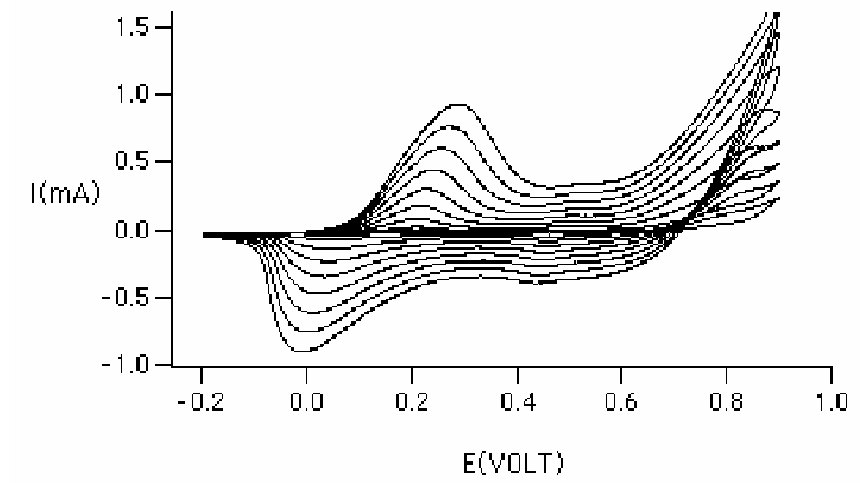
Figure 4 . Cyclic voltammograms (CV) recorded during growth for polyaniline. Scan rate= 20mV/sec. Electropolymerisation was carried out using a solution of 0.4M aniline in 1 M